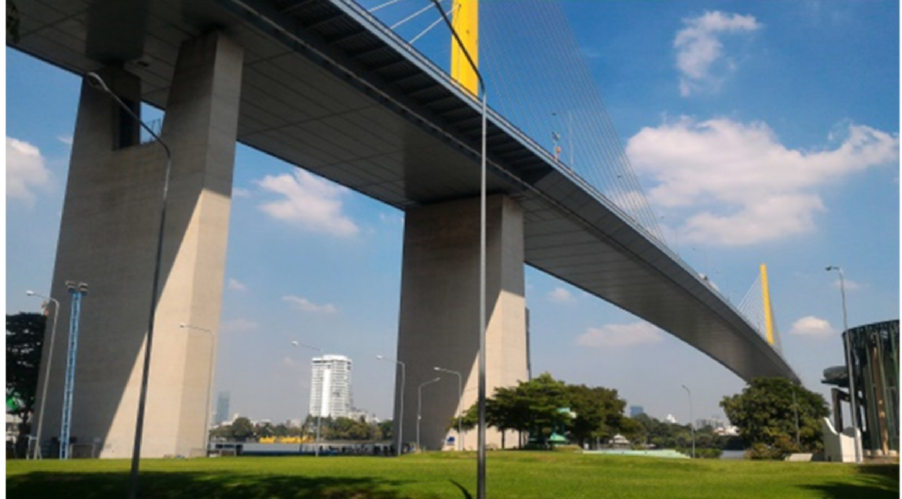
Figure 7. A view of Rama XI